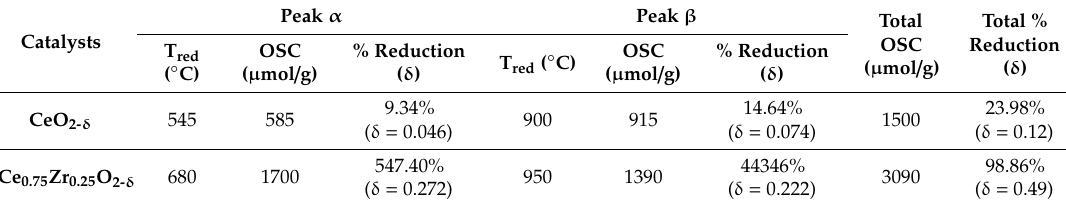
Table 1. H 2 - TPR results of CeO 2 and Ce 0.75 Zr 0.25 O 2 Table 1. H 2 -TPR results of CeO 2 and Ce 0.75 Zr 0.25 O 2